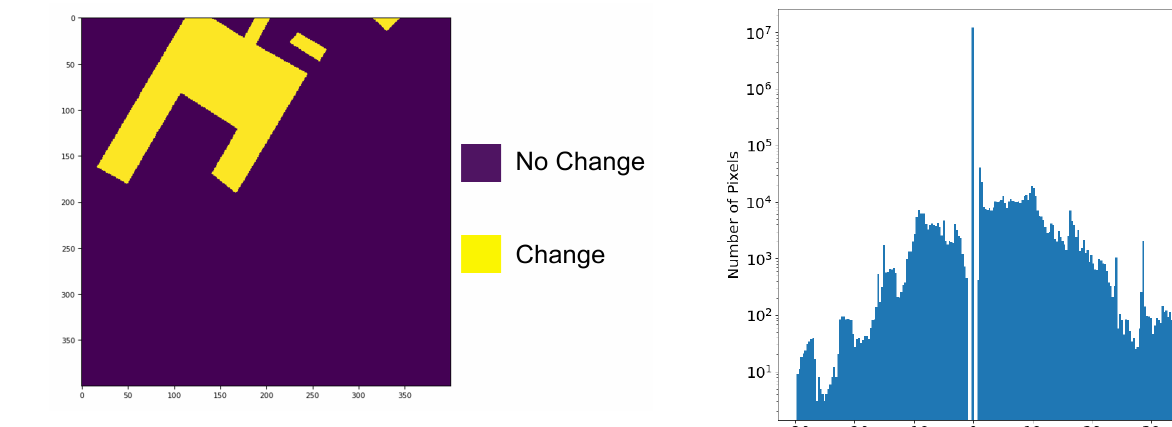
Figure 5. 2D change detection map